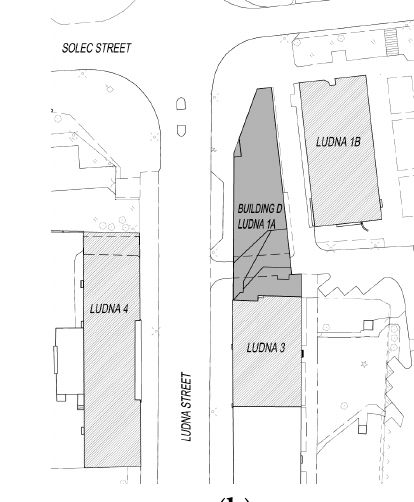
Figure 1. Building D with adjacent buildings ( a ) and location sketch ( b ).